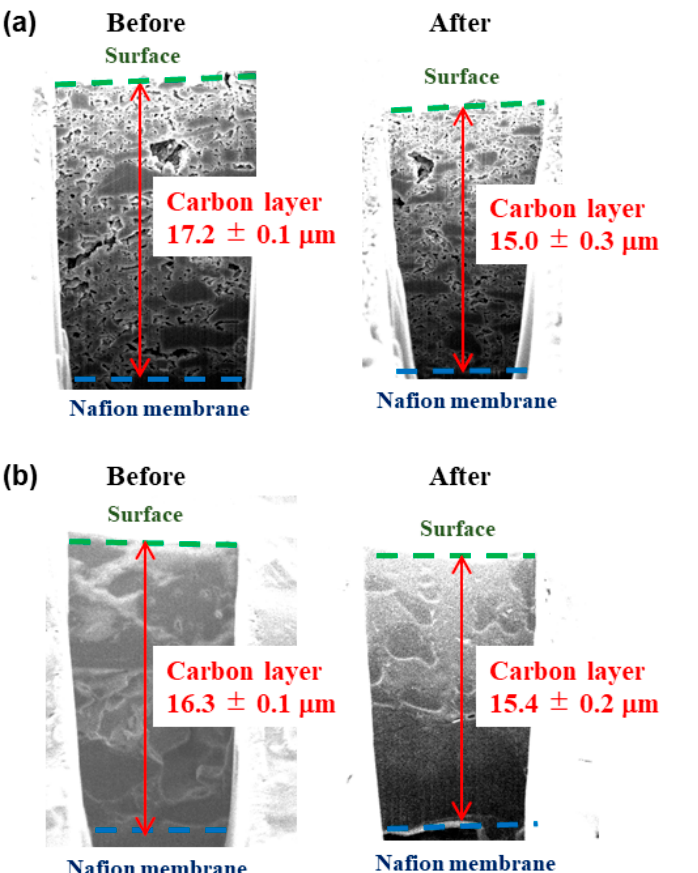
Figure 8. Cross-sectional view of bulk MC layer ( a ) and MCF-A layer ( b ) before and after the compression test. The thickness of each carbon layer is shown with red arrows.